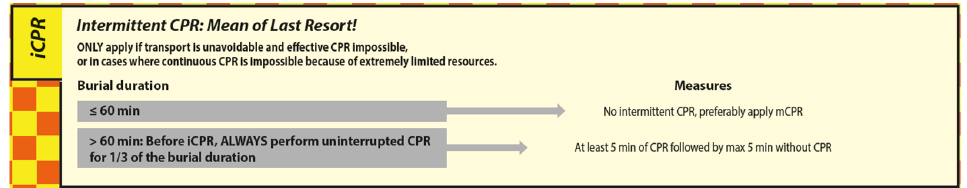
Figure 9. The iCPR module of